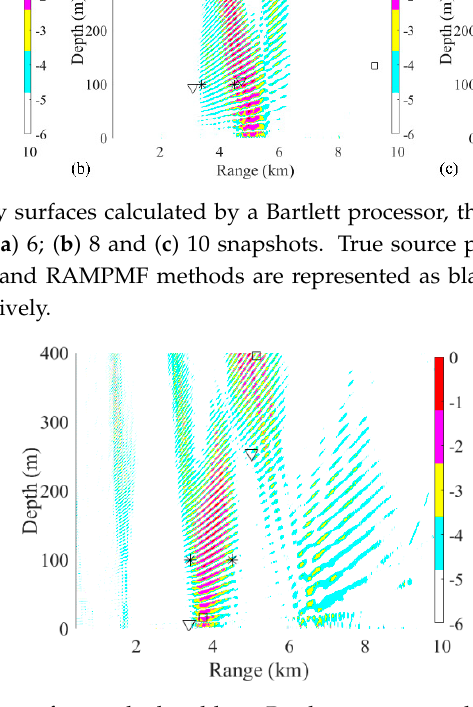
Figure 19. The ambiguity surfaces calculated by a Bartlett processor, the RAMP method, and the RAMPMF method with 8 m hydrophone spacing. True source positions and the positions estimated by the RAMP and RAMPMF methods are represented as black asterisks, squares, and inverted triangles, respectively.